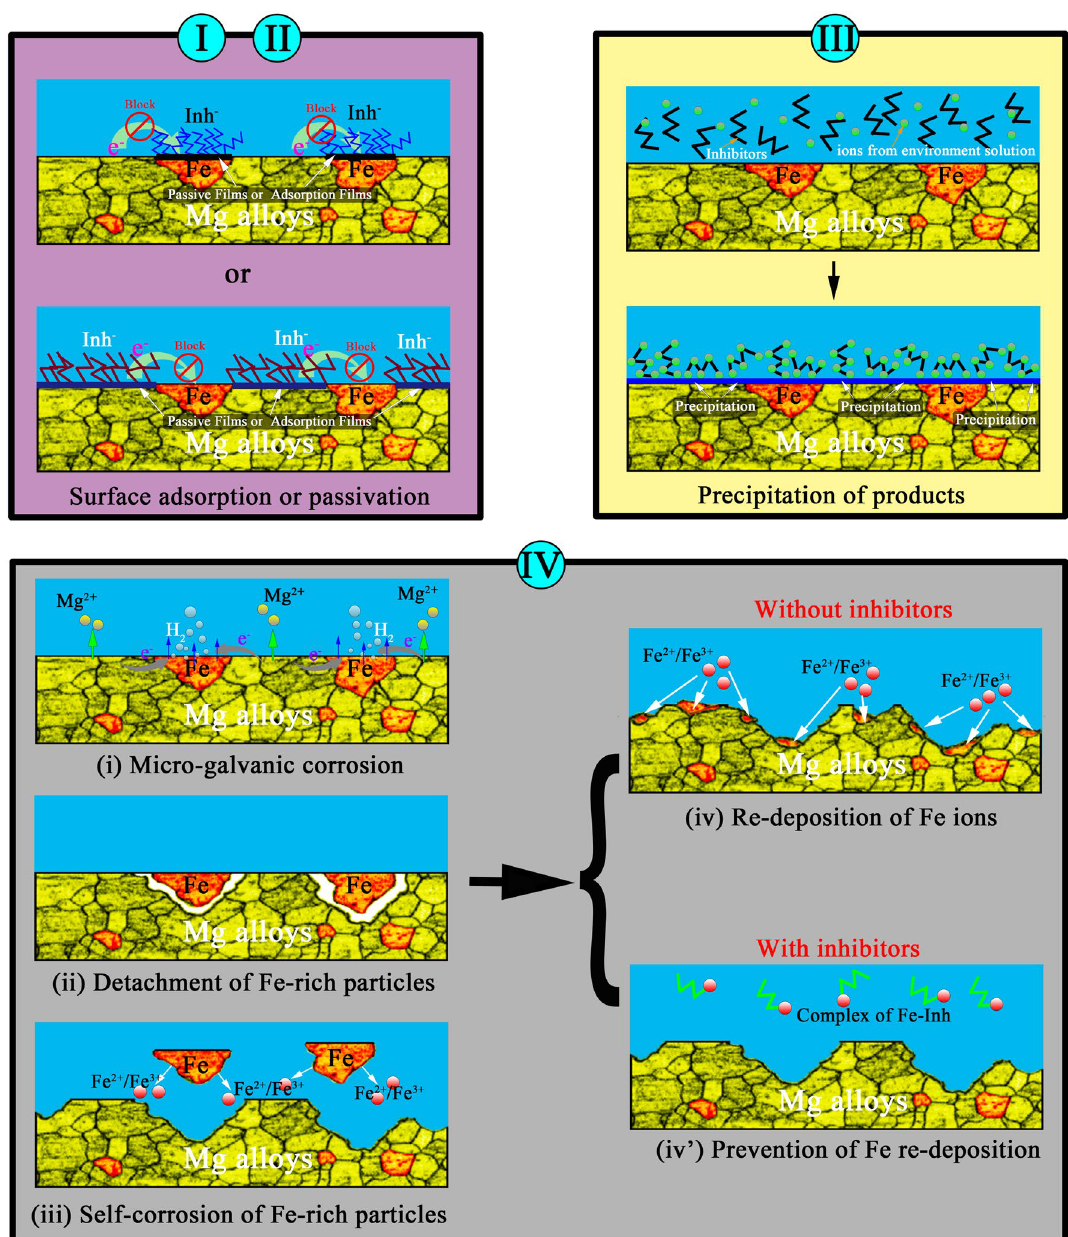
Figure 1. The schematic representation of inhibition mechanism of different kinds of corrosion